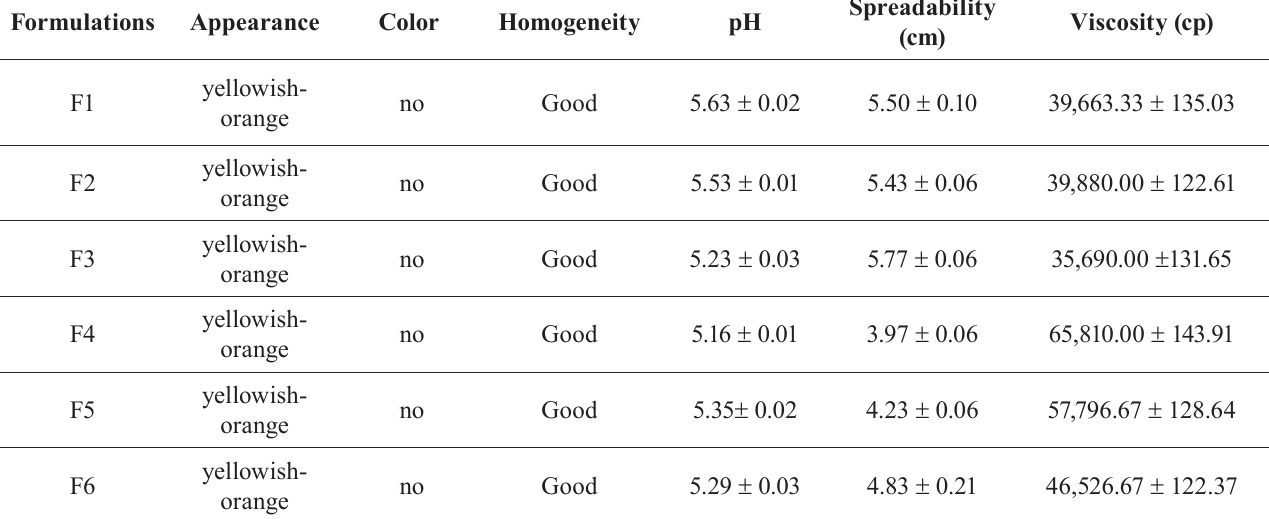
TABLE II - Physical properties of the prepared hydrogels of the Gac fruit extract